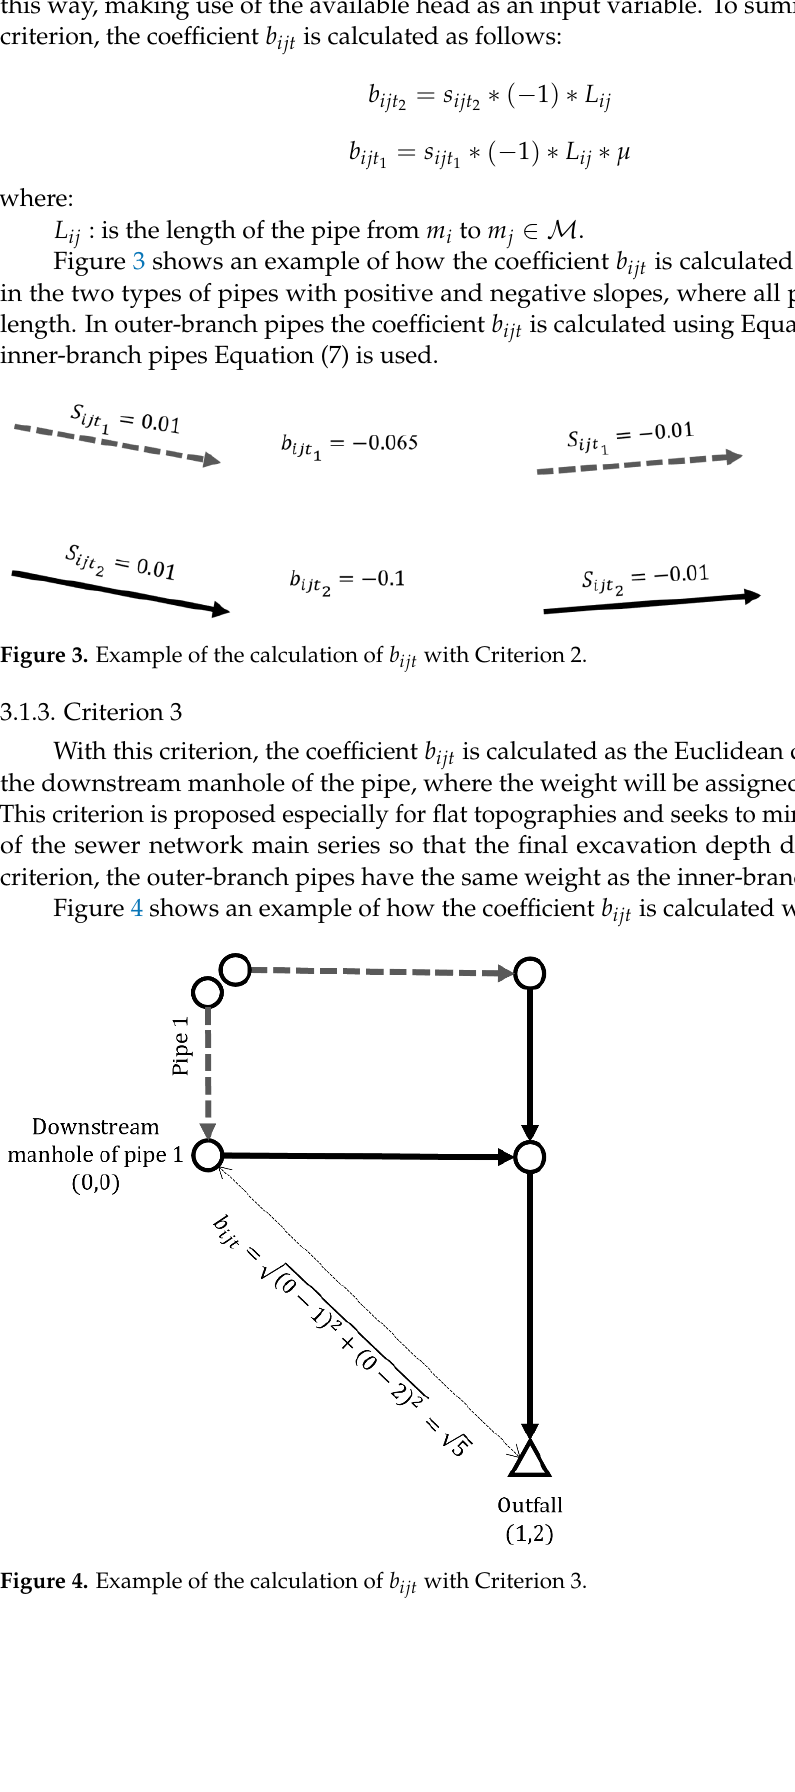
ijt with Criterion